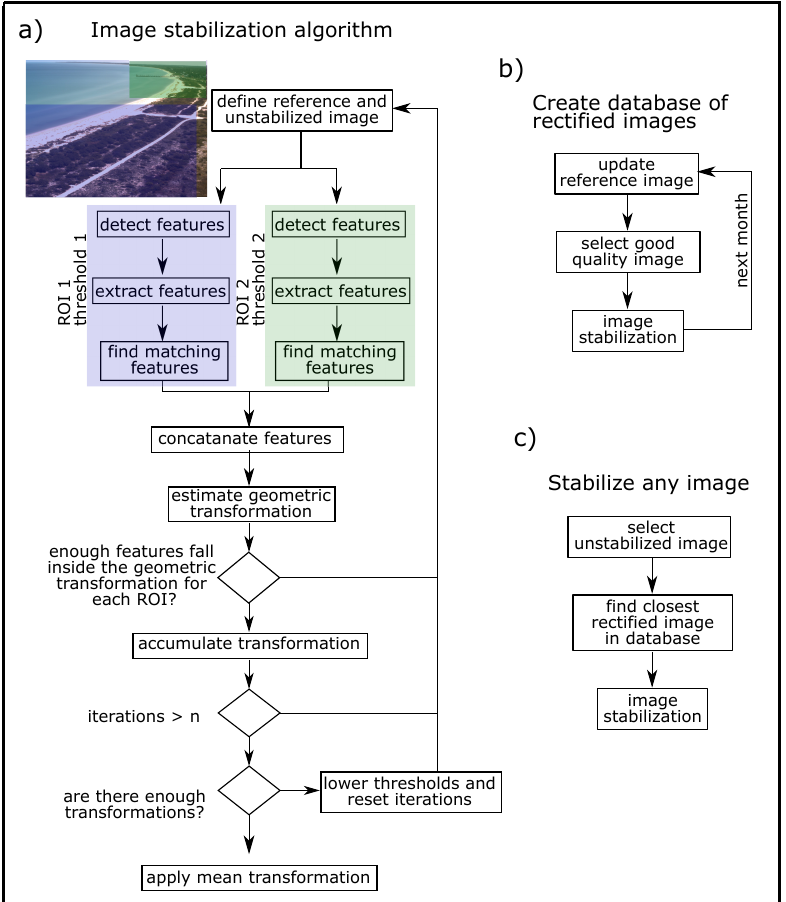
Figure 3. Flow diagram of the image stabilization algorithm ( a ). Flow diagrams ( b , c ) show the differ- ence in image reference selection to create a database of trusted rectified images and for stabilizing any image of interest,